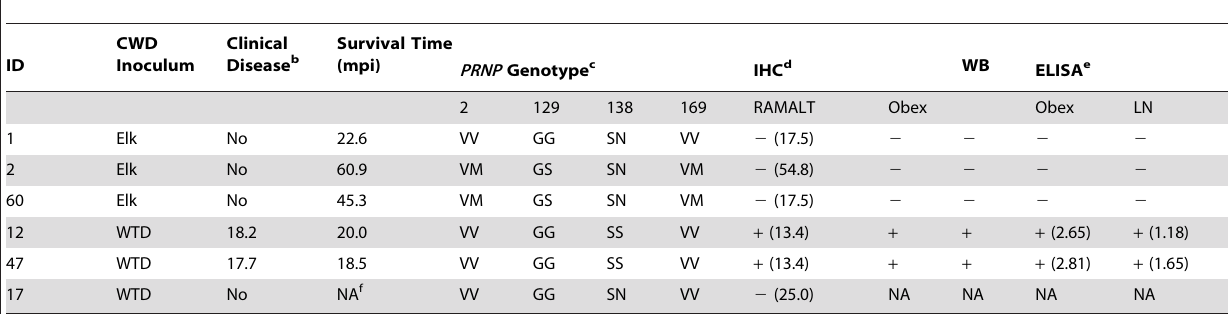
Table 1. Summary of results from reindeer orally inoculated with CWD from elk or white-tailed deer. a